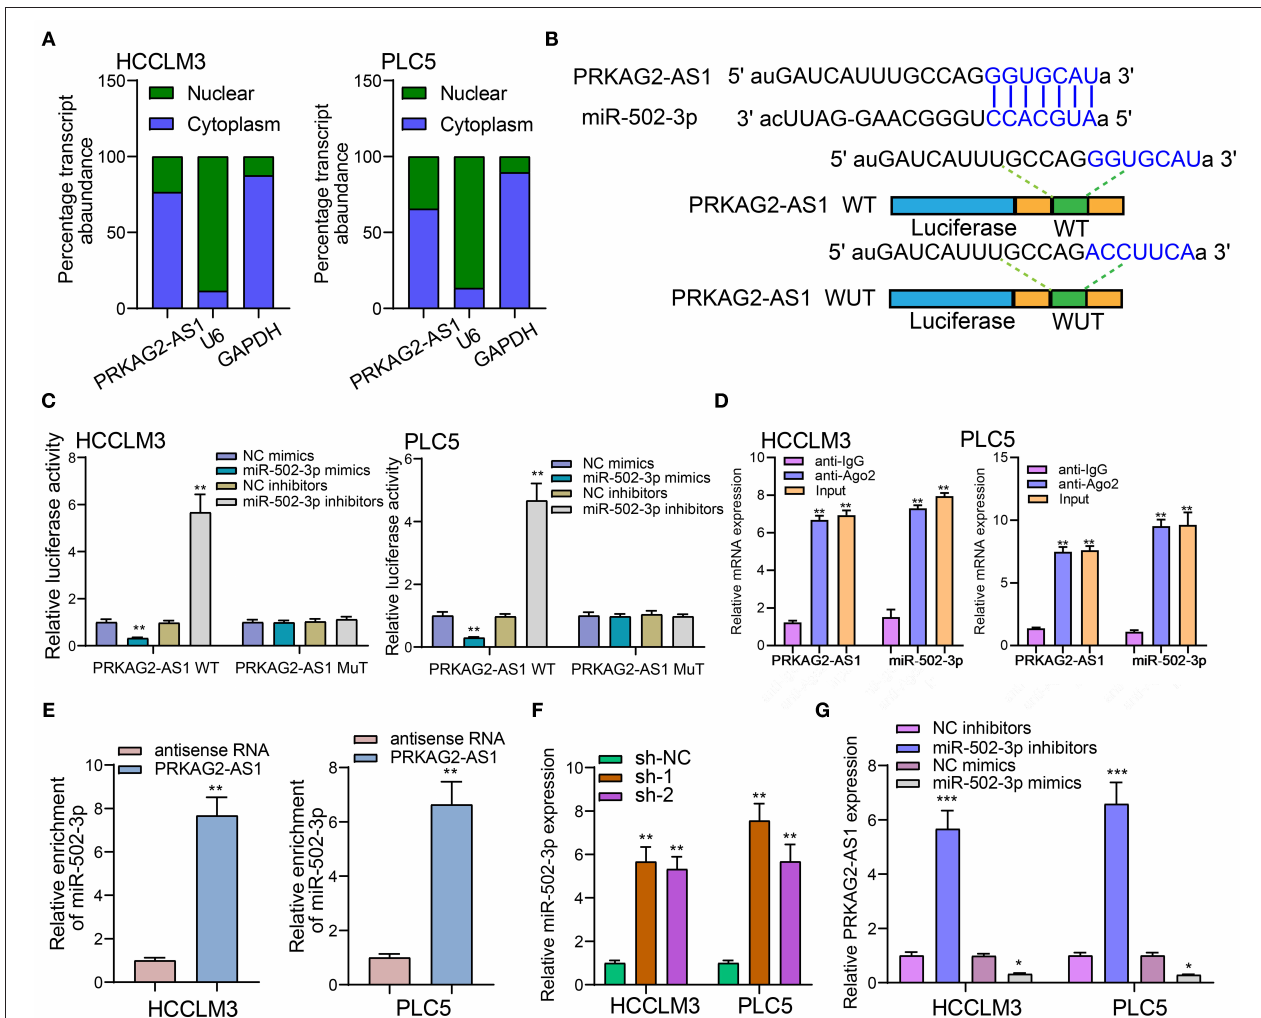
FIGURE 5 | LncRNA PRKAG2-AS1 can bind to miR-502-3p. (A) The cellular distribution of PRKAG2-AS1 expression. U6 as a control of nuclear and GAPDH as a control of cytoplasm. (B) The schematic diagram of the binding sites between PRKAG2-AS1 and miR-502-3p. (C) The luciferase reporter assay results confirming the direct binding relationship between PRKAG2-AS1 and miR-502-3p. (D) RIP results for the binding of PRKAG2-AS1 to Ago2. (E) RNA pull-down for the enrichment levels of miR-502-3p in HCC cells transfected with PRKAG2-AS1-WT and PRKAG2-AS1-MuT. (F) RT-qPCR for detection of miR-502-3p expression in HCC cells with PRKAG2-AS1 knockdown. (G) RT-qPCR examining PRKAG2-AS1 expression in HCC cells transfected with miR-502-3p mimics or inhibitors. * p < 0.05; ** p < 0.01; *** p <